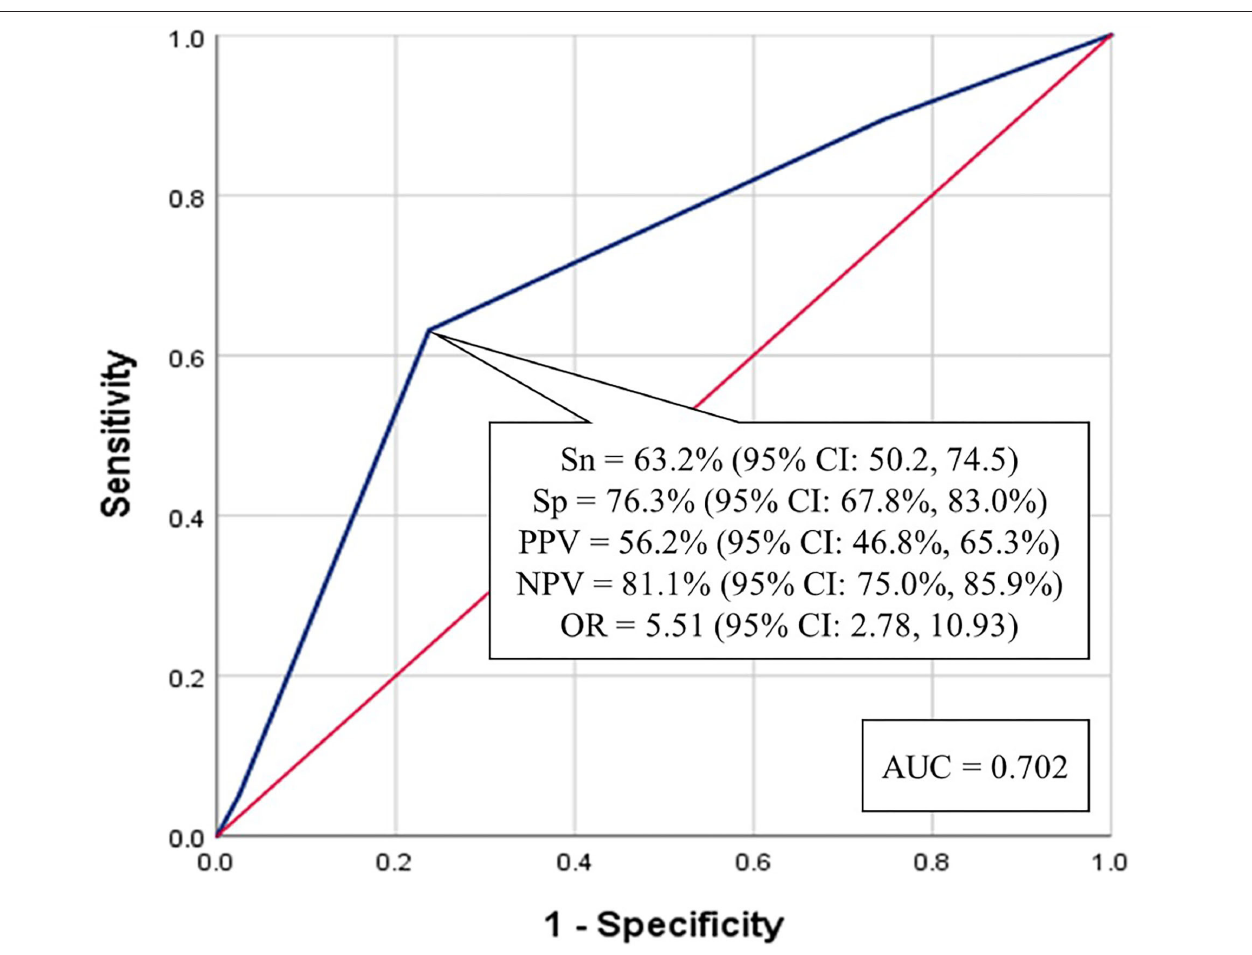
FIGURE 3 | Receiver operator characteristic analysis for the optimum number of predictors ( ≥ 2) from the three-factor model.